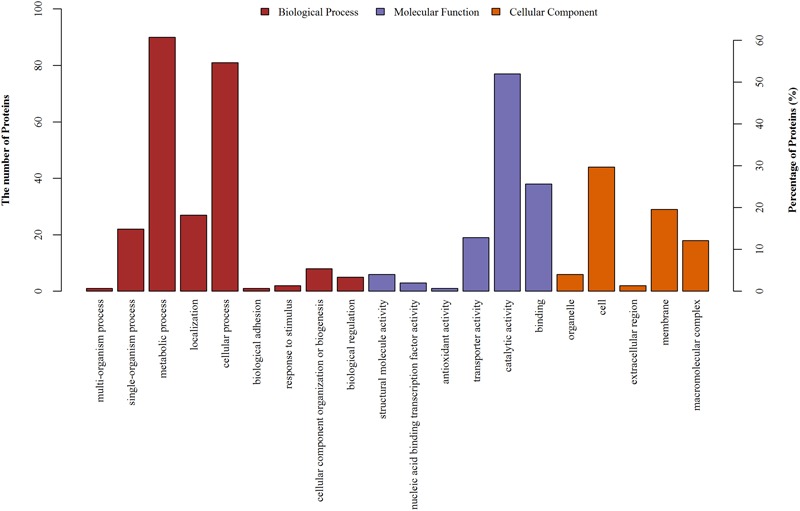
GO annotation of differentially regulated protein (ratio: > 1.2 or < 0.8) functions. Y-axis represented the number of identified proteins in each GO category.